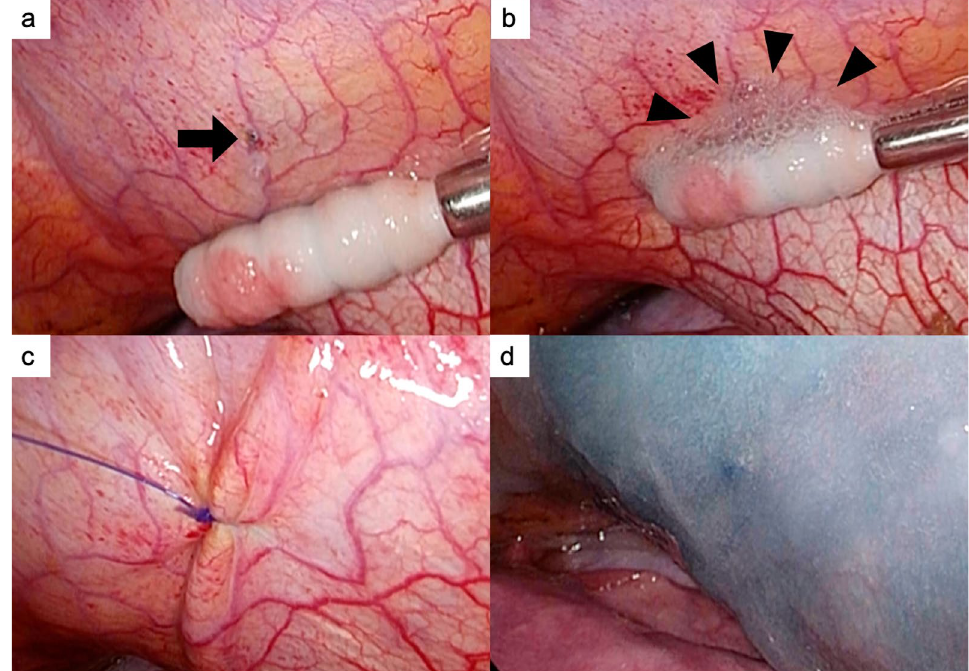
Fig. 3 Surgical findings of case 1. a A pore was detected on the central tendon of the diaphragm with a thoracoscope (arrow). b Bubbles were observed in this small pore after pneumoperitoneum (arrowhead). c Small pores were closed with a single 4–0 non-absorbable monofilament Z suture. d The central tendon around the reinforcement was covered with a sheet of absorbable polyglycolic acid felt and sprayed with fibrin glue on the thoracic